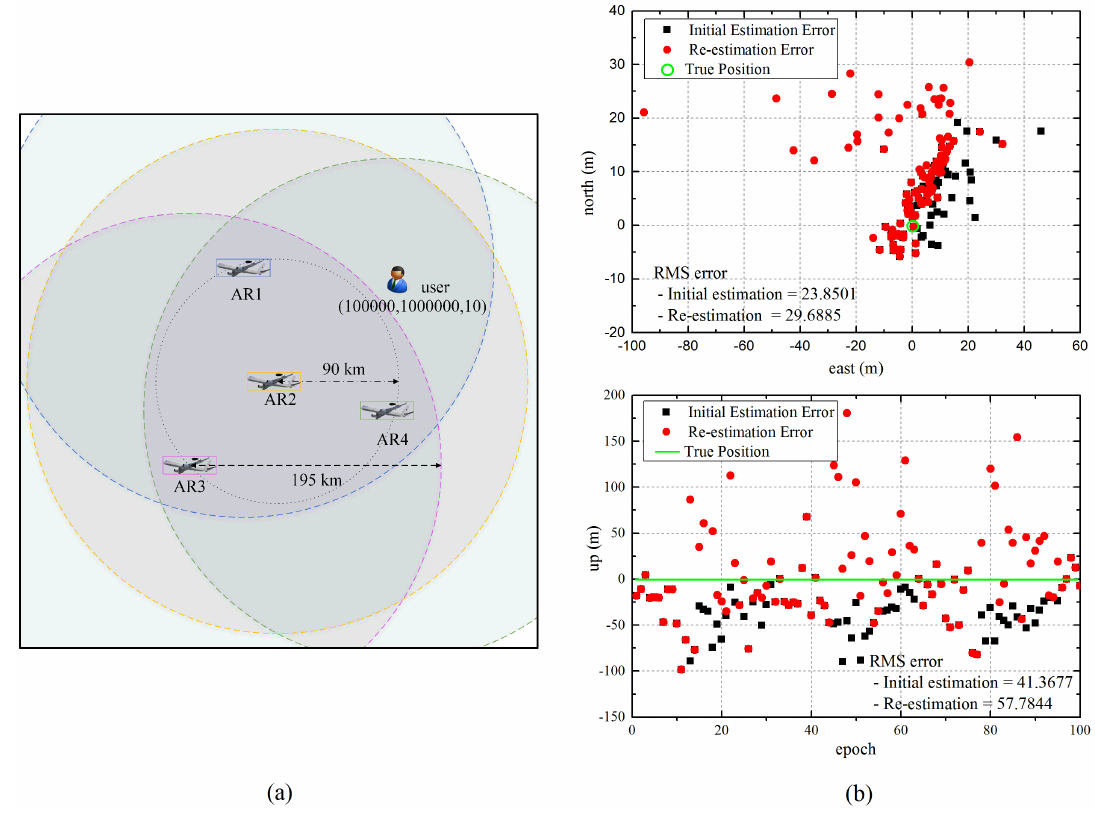
Figure 8. East, north and up (ENU) errors of the user positioning outside a coverage area. ( a ) User position in the simulation; ( b ) ENU errors of a